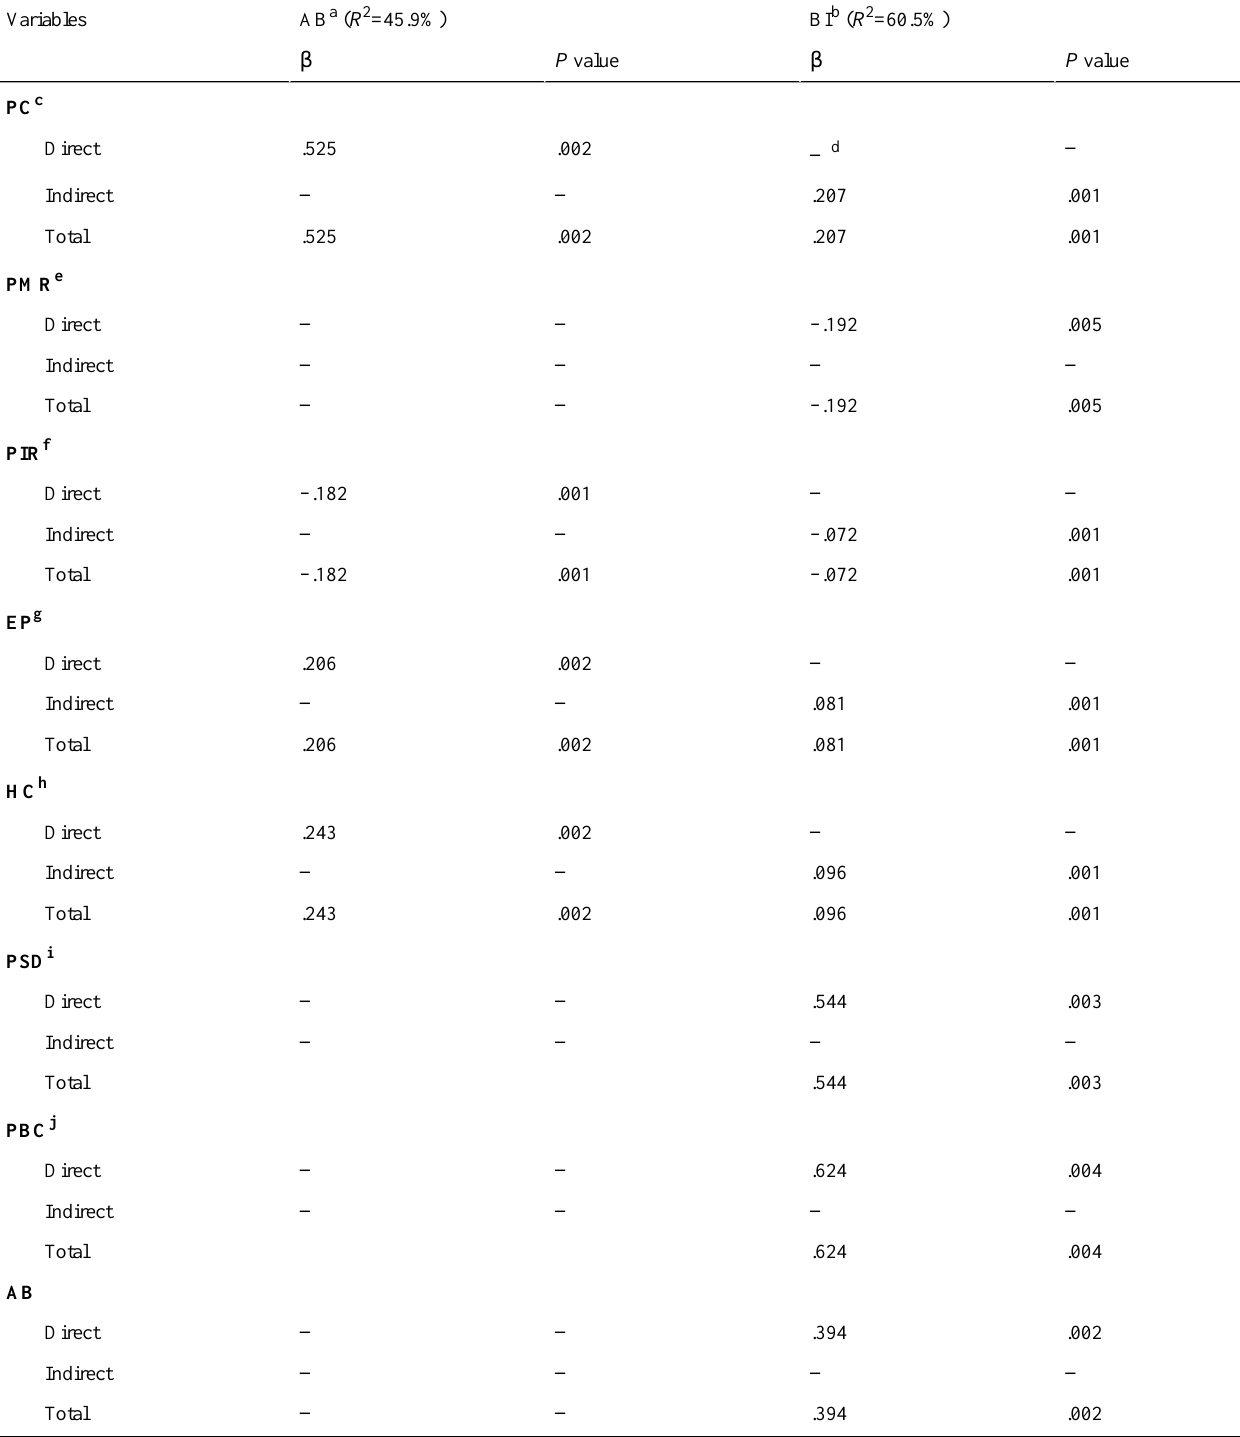
Table 6. Total, direct, and indirect effects of the model